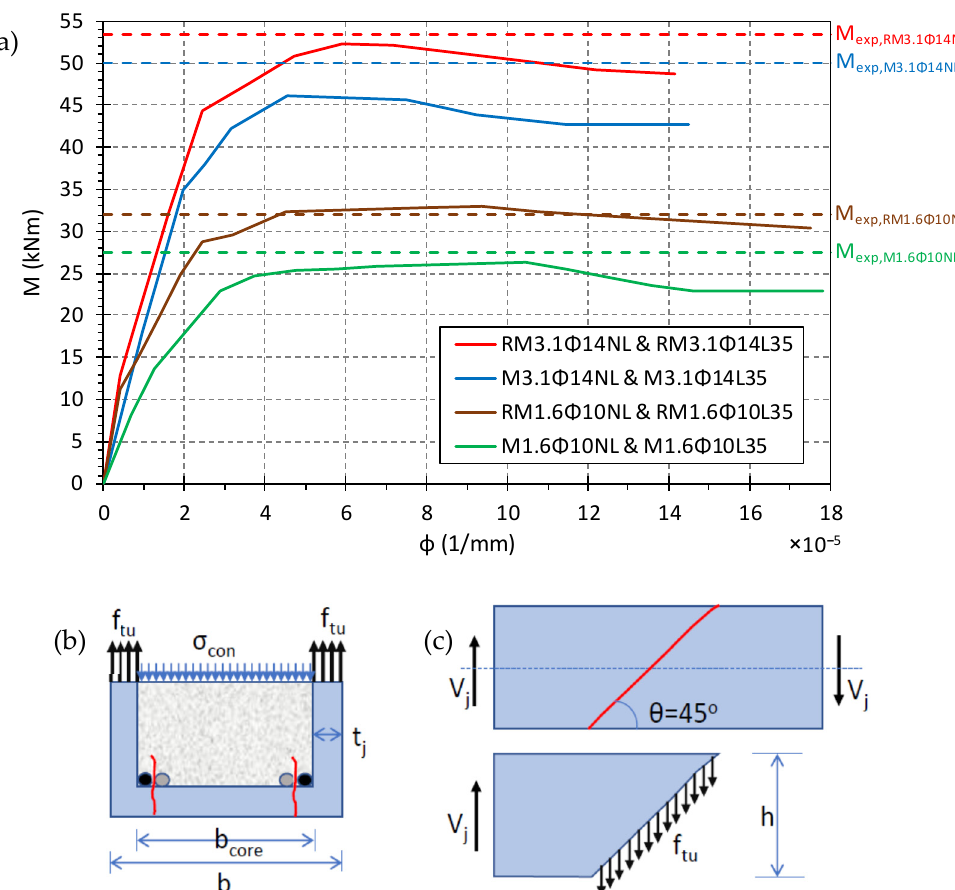
Figure 13. ( a ) Moment vs. curvature relationships: M1.6 Φ 10 Ν L vs. RM1.6 Φ 10 Ν L, and M3.1 Φ 14 Ν L vs. RM3.1 Φ 14 Ν L. ( b ) Estimation of confinement stress, and ( c ) shear stress contribution provided by the ECC jacket.